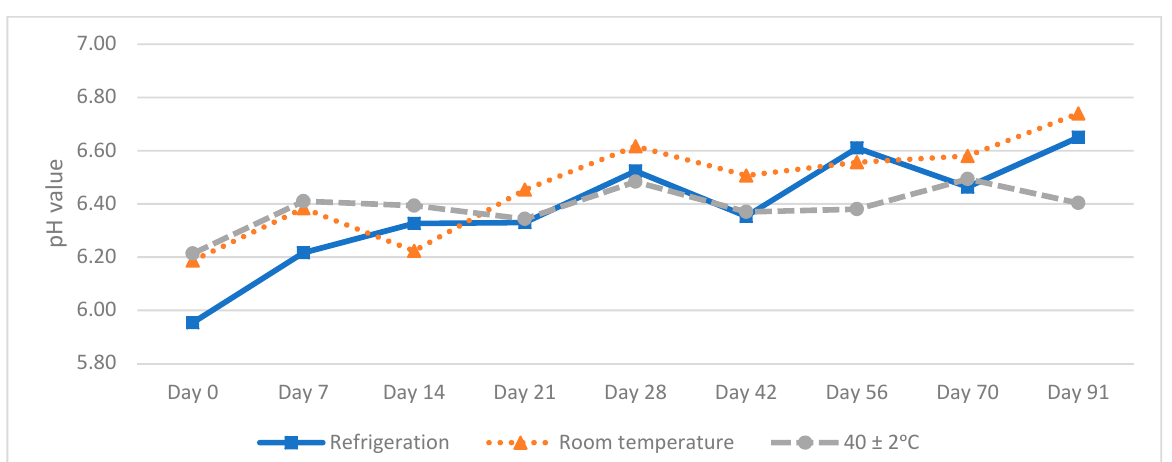
Figure 3. pH values of methadone hydrochloride (10 mg/mL) without the preservative (M1) oral solution.